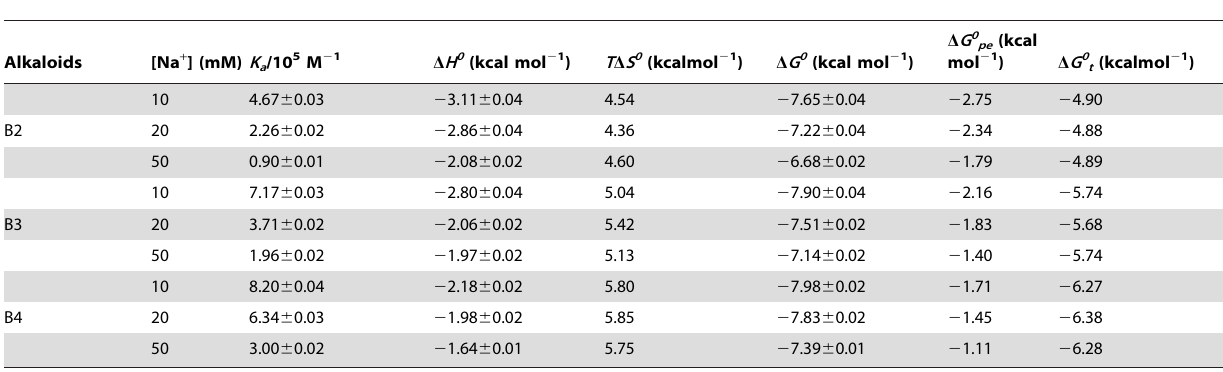
Table 3. Thermodynamic parameters for the association of alkaloids with tRNA from ITC at different salt concentrations a .